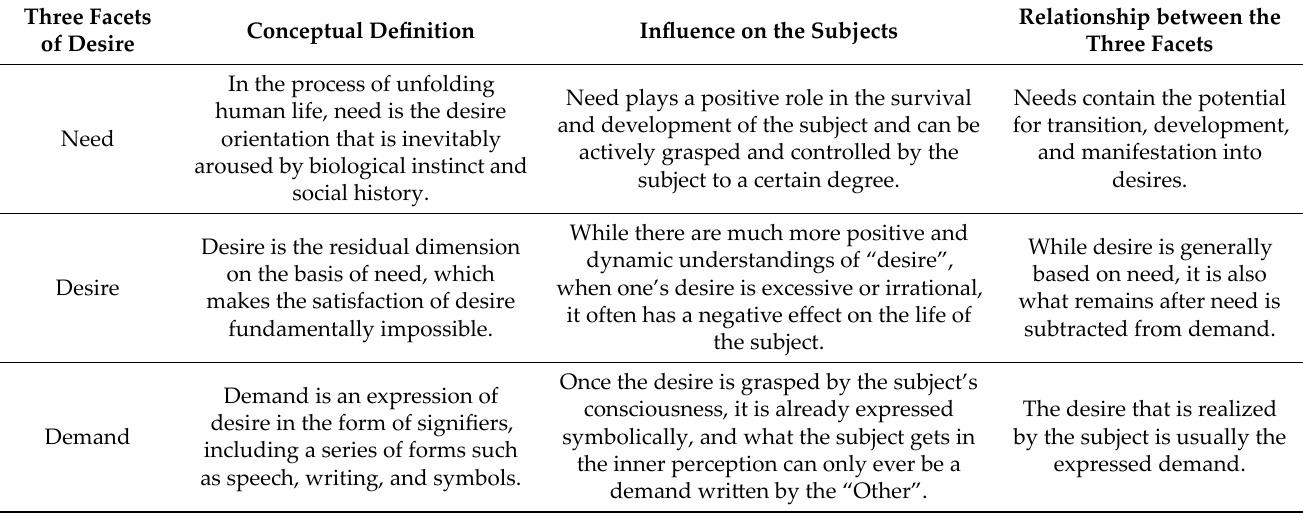
Table 1. Three facets of desire: definition, influence, and